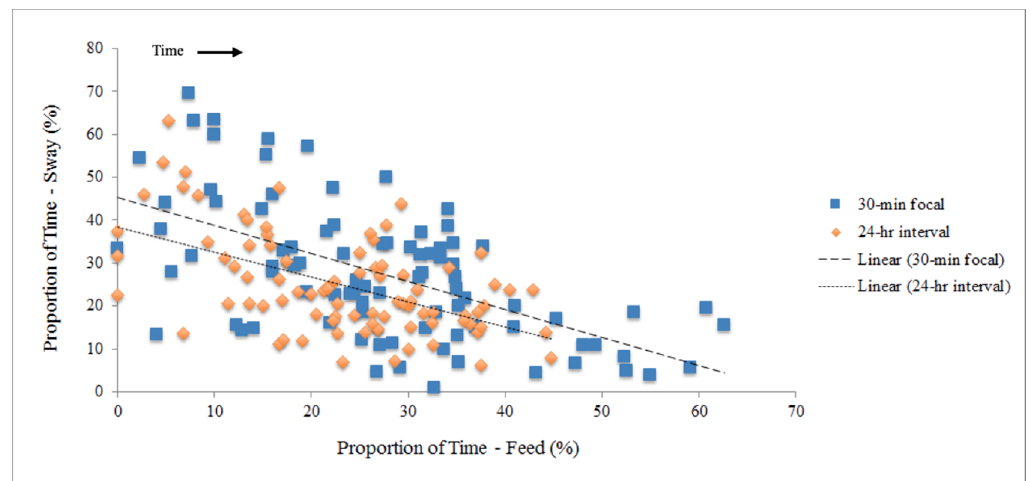
Figure 4. Linear regressions testing correlation of swaying and feeding behaviors observed during 30 min focal and 24 h interval sampling. Values are derived from weekly averages.